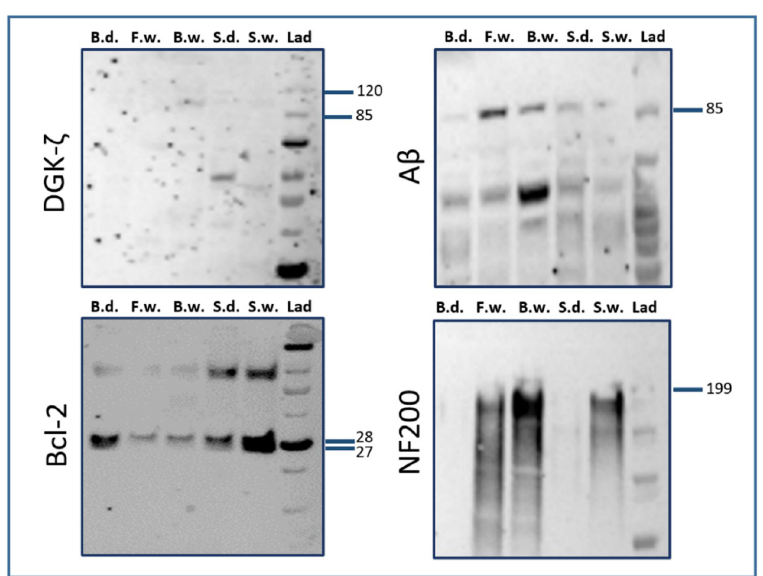
Fig 1. Results of WB analyses for antibodies against DGK- z , Bcl-2, A β , and NF200. B.d.: Bottlenose dolphin; F.w.: Fin whale; B.w.: Beaked whale; S.d.: Striped dolphin; S.w.: Sperm whale; Lad: Ladder. Labels on the right of each panel signify molecular weight in